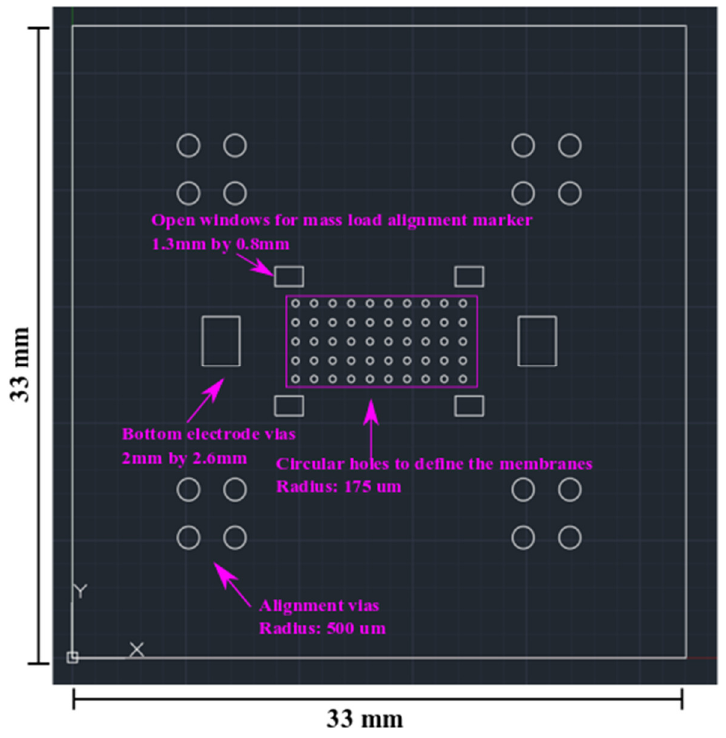
Figure 7. Mass sensor polyimide spacer layer laser micromachining design.